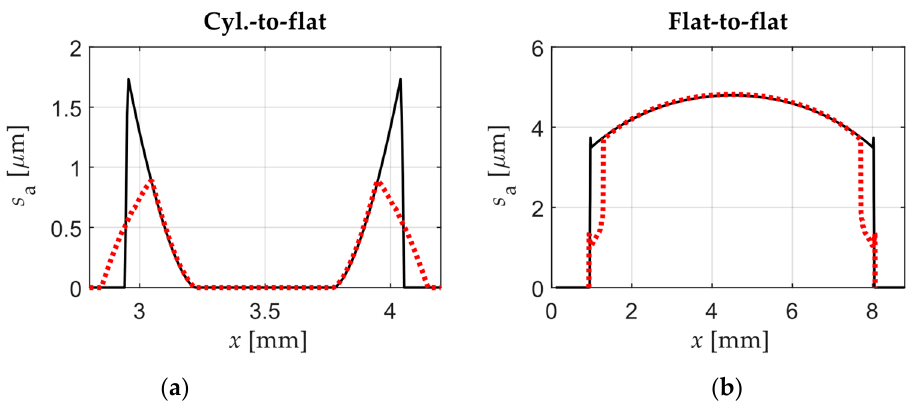
Figure 14. ( a ) Slip amplitude along the contact in case 2 with cyl.-to-flat contact for the 1st scenario (black continuous line) and 2nd scenario (red dotted line); ( b ) Slip amplitude along the contact in case 3 with flat-to-flat contact for the 1st scenario (black continuous line) and 2nd scenario (red dotted line).